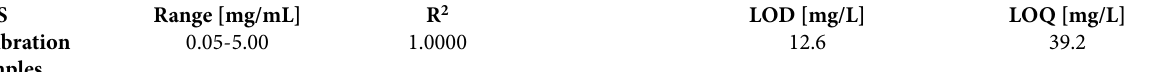
Table 2. Validation data of the analytical method for hydrocortisone sodium succinate (HSS) quantification. HSS